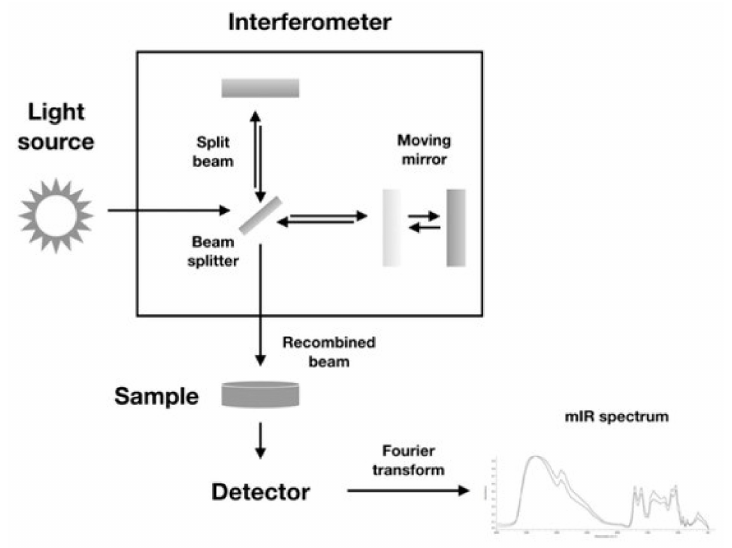
Figure 7. FTIR spectroscopy setup